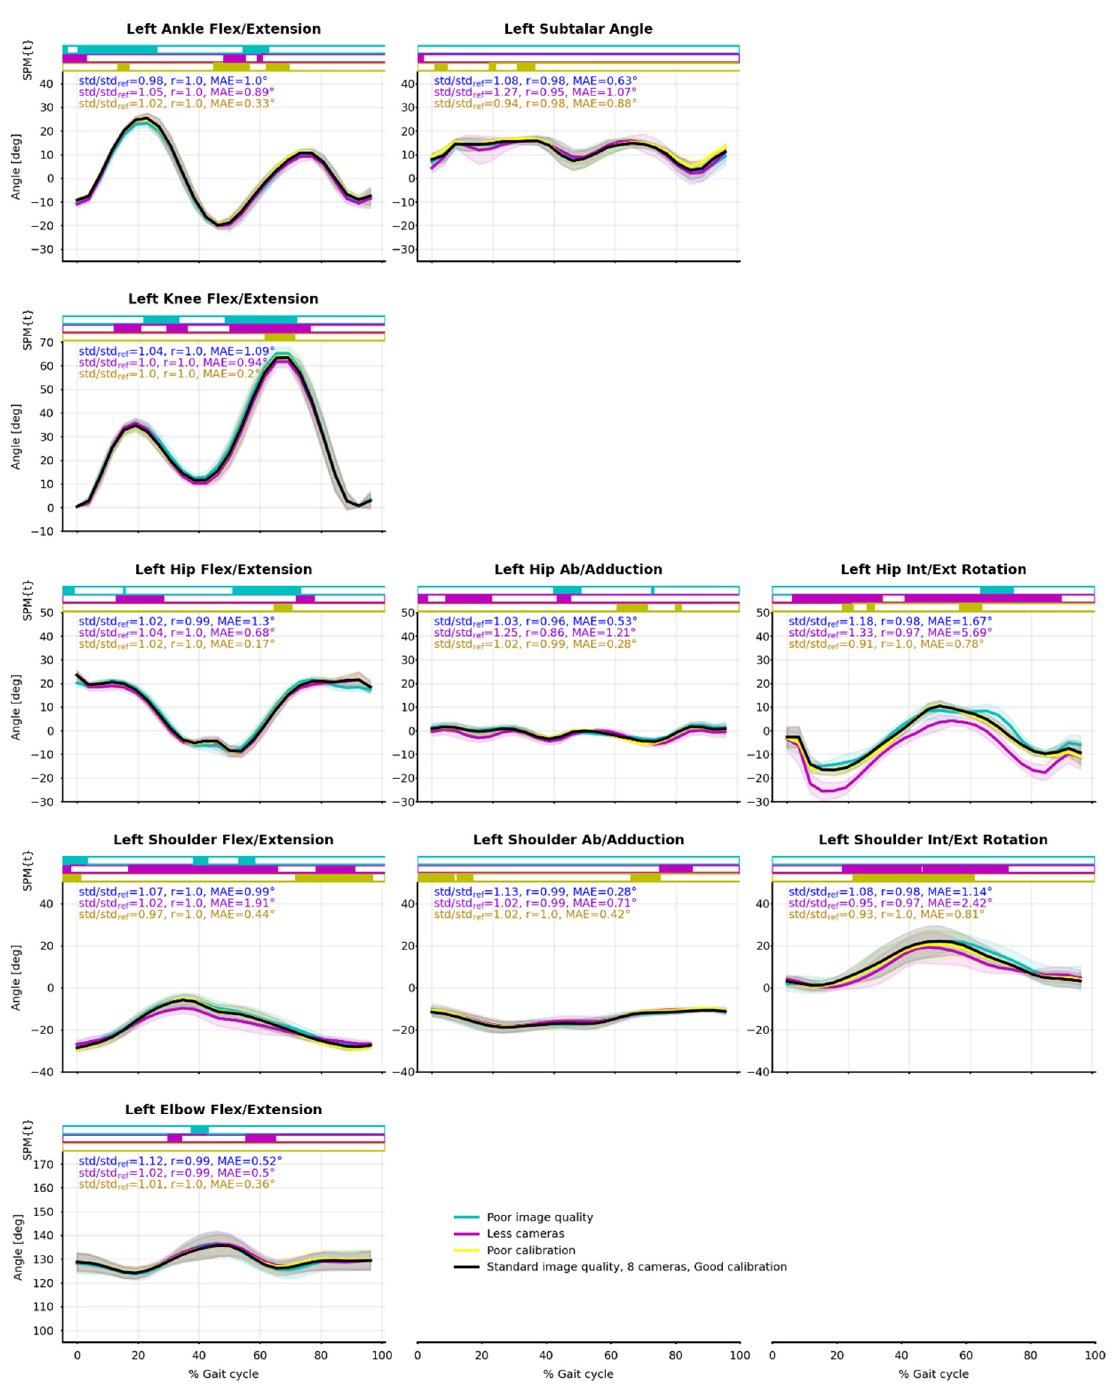
Figure A1. Joint angle means (solid line) and standard deviations (shaded area) from the nine captured cycles of running. Reference condition (Ref) is black; degraded image quality (Im) is blue; four cameras instead of eight (4c) is purple; degraded calibration (Cal) is yellow. Pearson’s correlation coefficient (r) and mean absolute error (MAE) between Ref and Im, 4c, Cal were calculated. Paired t-tests along time were computed by SPM-1D and are represented as bar plots above the curves: a color rectangle means that there was a cluster of statistically significant differences ( α = 0.05) at that moment.